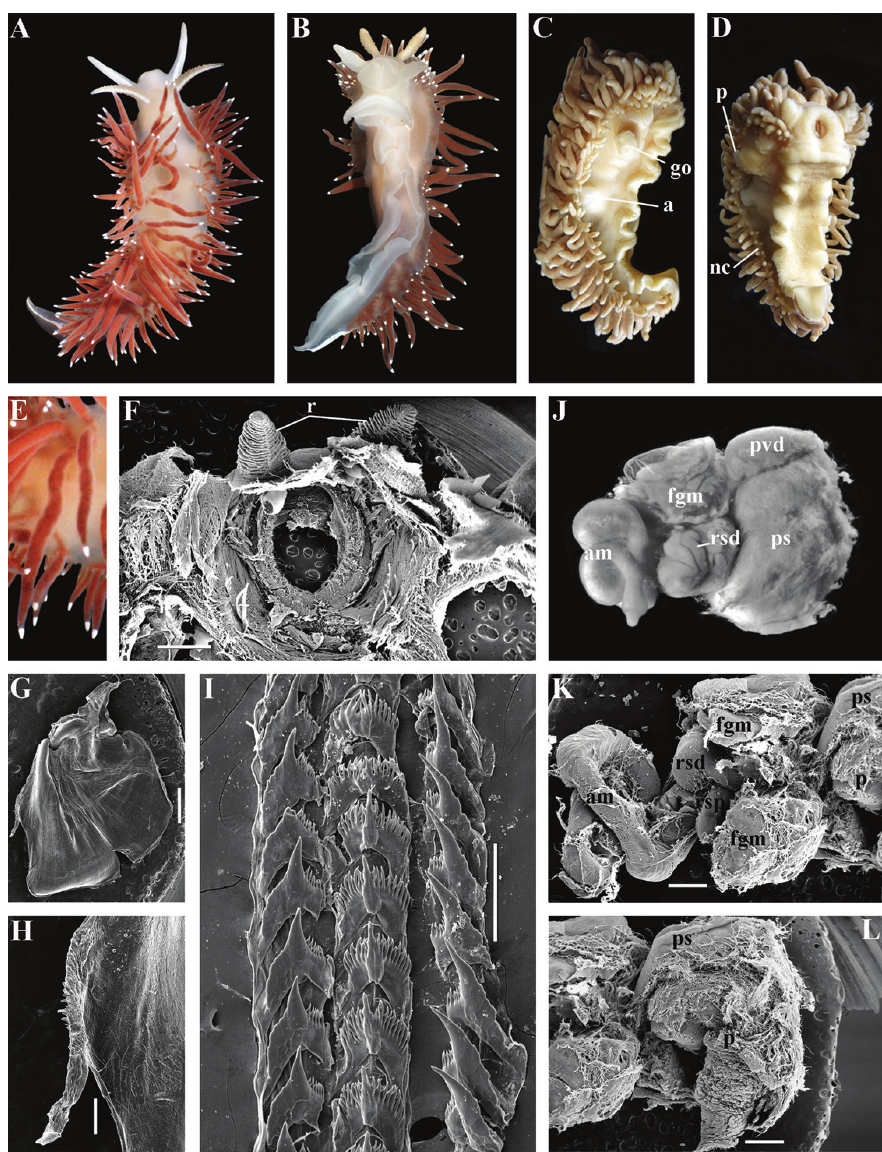
Figure 28. Himatina trophina (Bergh, 1894). North West Pacific, Kamchatka. ZMMU Op-29, living specimen 32 mm length: A dorsal view B ventral view ZMMU Op-532, fixed specimen 27 mm length C lateral view D ventral view E details of cerata ZMMU Op-29 F dissected anterior part (pharynx re- moved) and rhinophores, SEM G jaw, SEM H details of masticatory process of jaw SEM I radular teeth, posterior part, SEM J reproductive system, light microscopy K reproductive system SEM L penis, SEM. Abbreviations: a anus am ampulla fgm female gland mass go genital opening nc continuous notal edge p penis ps penial sheath r rhinophores rsd distal receptaculum seminis rsp proximal receptaculum semi- nis. Scale bars: G, K, L = 1 mm; H = 30 μm; I =10 μm. Photos and SEM images by T.A. Korshunova, A.V.